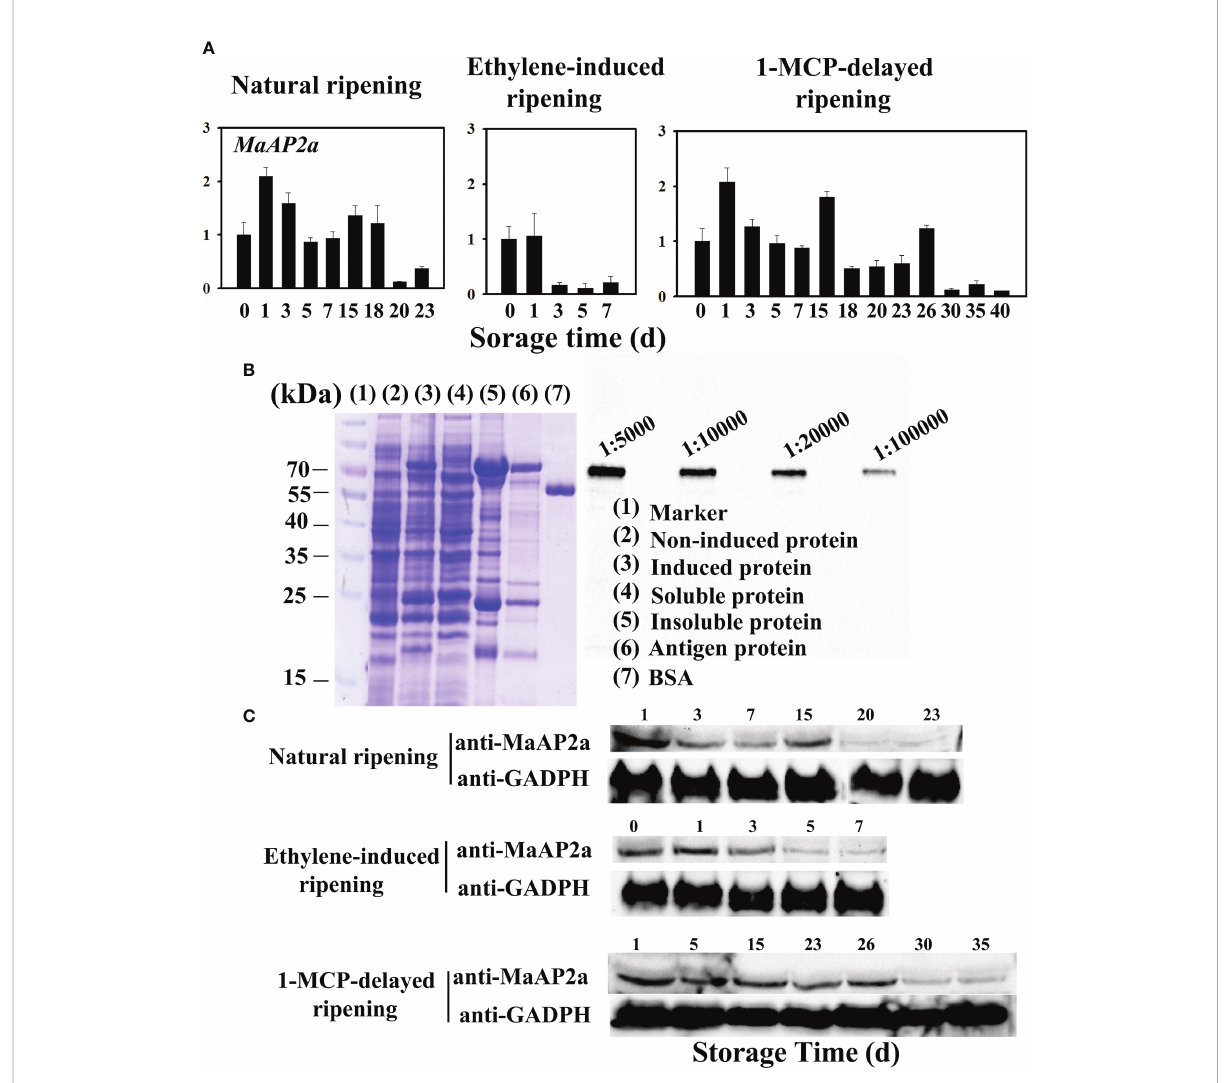
FIGURE 3 Gene transcriptional expression and translation protein pro fi le of MaAP2a in banana fruit pulp in three different ripening behaviors. (A) The relative transcript levels of MaAP2a are shown as a ratio relative to the 0 day of natural ripening, which was set as 1. Each value represents the mean ± SE of three replicates. (B) Preparation of polyclonal antibody against MaAP2a and speci fi city analysis of antibody by Western blotting with four gradient concentrations of antibody from 1:5,000 to 1:100,000. (C) Western blot analysis of protein level of MaAP2a in banana pulp with three different ripening behaviors. Anti-GADPH antibody was used as a reference control to normalize the loading